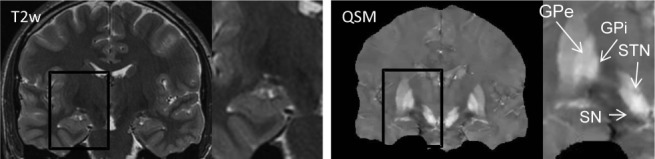
Quantitative susceptibility mapping for visualizing deep brain stimulation targets. Globus pallidus interna (GPi) and subthalamic nucleus (STN), surgical targets for deep brain stimulation, are either invisible or inseparable from surrounding tissues on T2W image (with zoom), but are clearly visualized on deep brain stimulation (QSM) (with zoom). Other basal ganglia structures well-defined on QSM include globus pallidus pars externa (GPe) and substantia nigra (SN). Source: Liu et al, Radiology 2013;269:216–23.